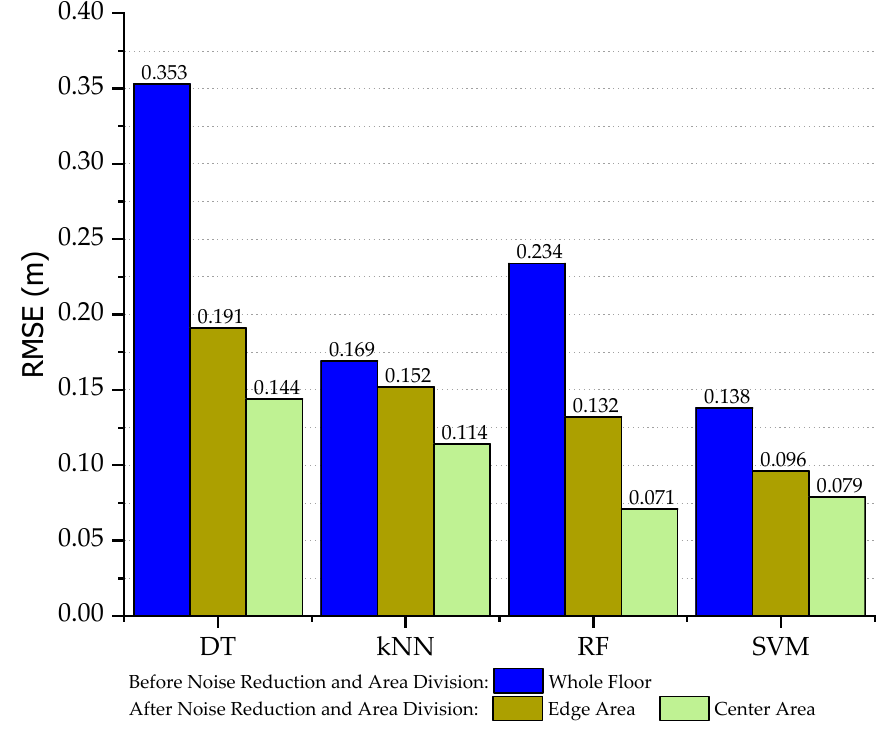
Figure 22. RMSE comparison. Table 5. Root mean square error (RMSE) comparison